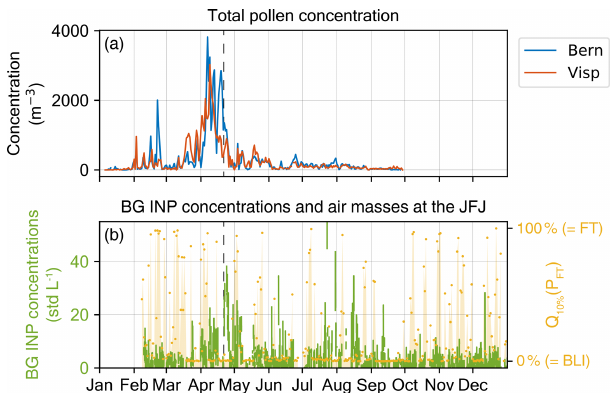
Figure 3. Timeline of the total pollen concentration at Bern and Visp (a) and the corresponding BG (excluding SDE) INP concen- tration (high-resolution) at JFJ with the Q 10% of P FT of a given day (b) between February 2020 and the end of December 2021. The dashed black line indicates the peak in INP concentrations in April. Pollen data are only available between early January and the end of September. Pollen data courtesy of